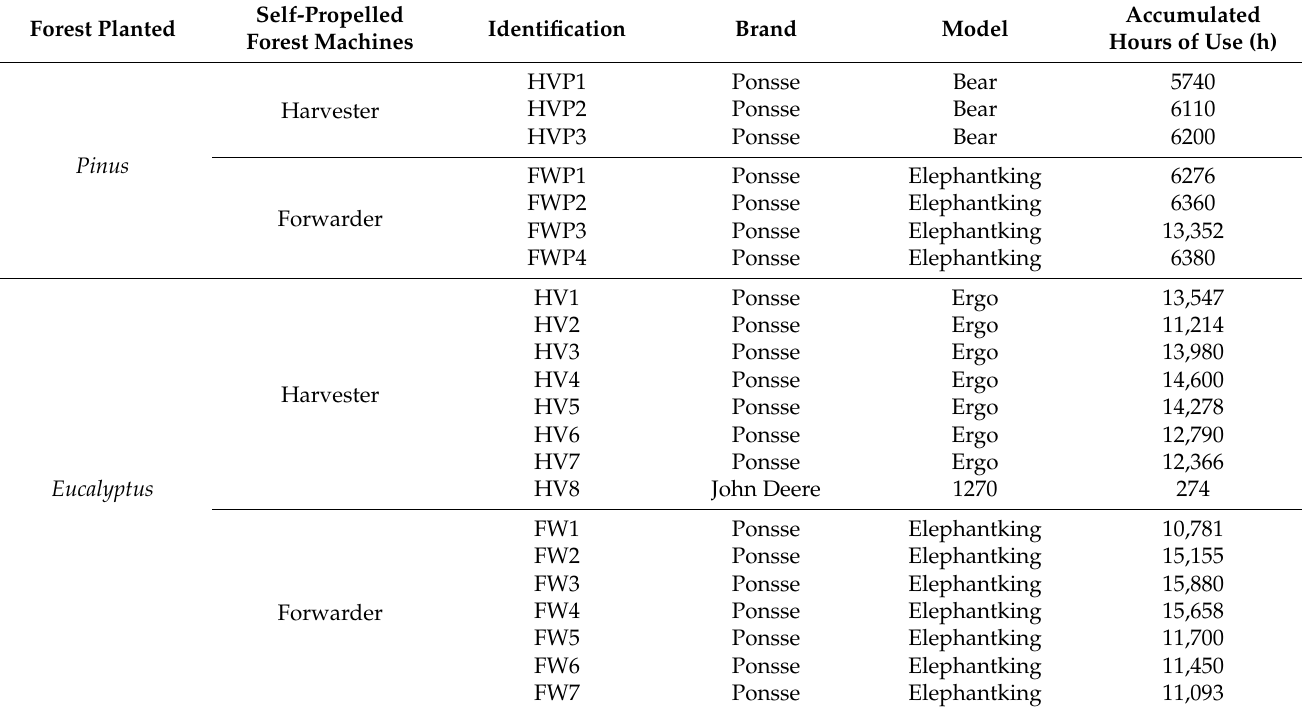
Table 2. Identification, brand and model of self-propelled forestry machines and accumulated hours of use. Self-Propelled Forest Planted Forest